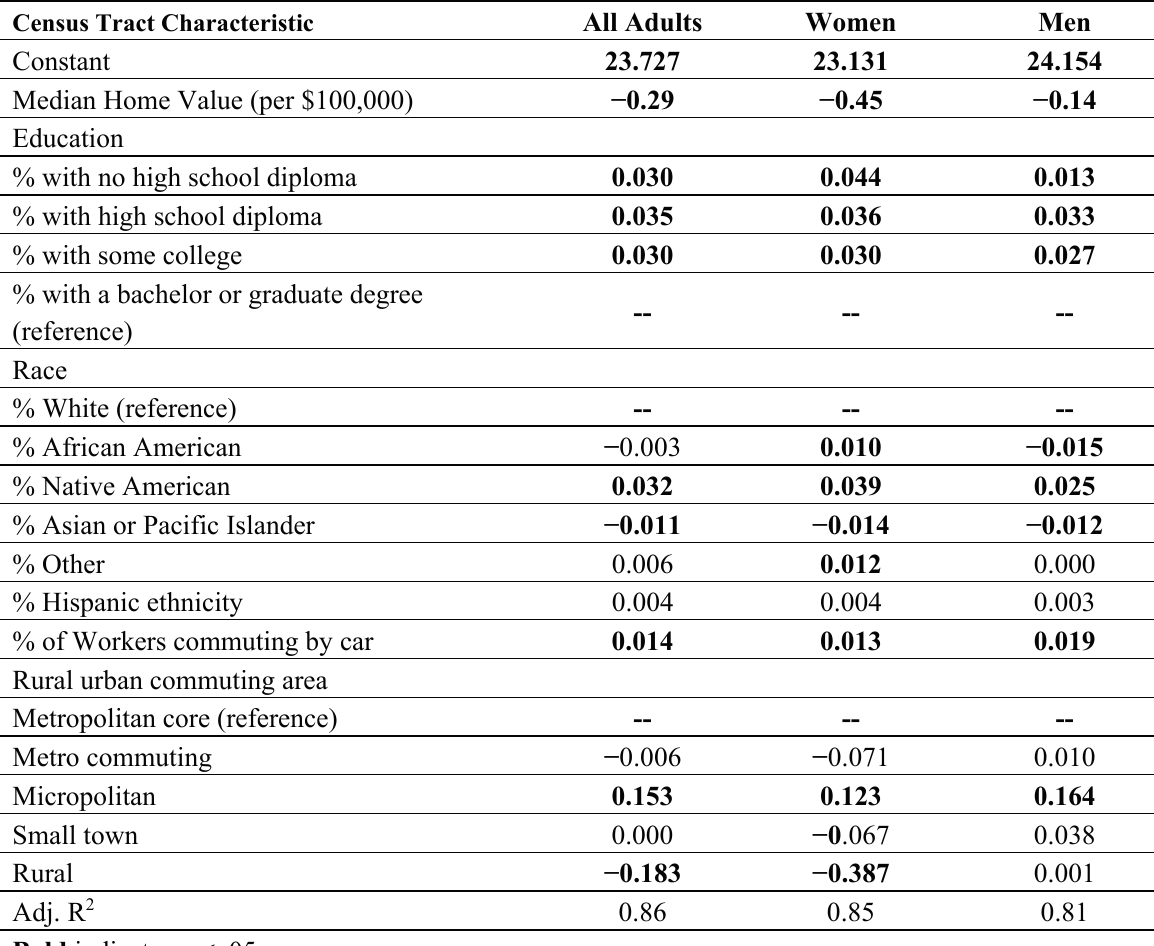
Table 2. Linear regression results on age-adjusted mean BMI, statewide analysis by census tract (N =